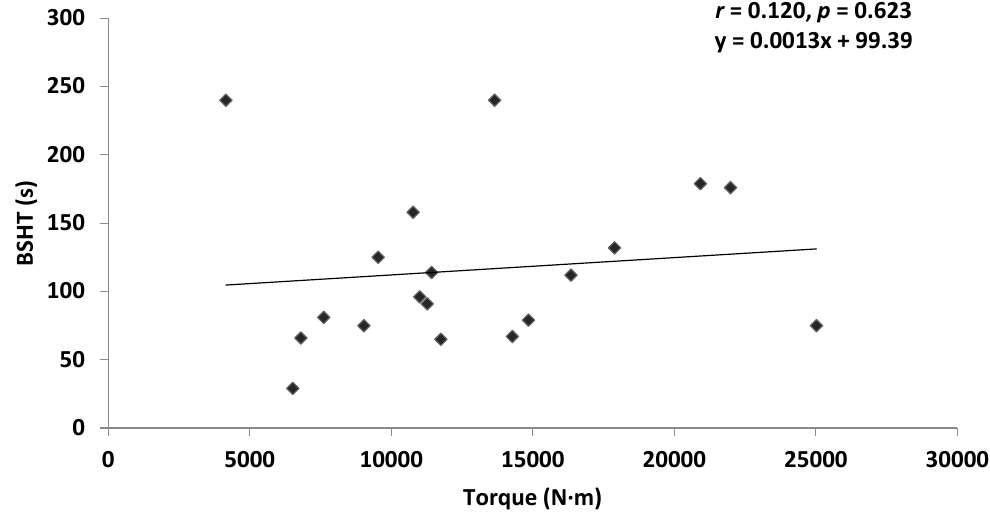
Figure 4. Scatter plot of chronic lower back pain (CLBP) data for ILEX strength (SI) and TEX endurance (BSHT).